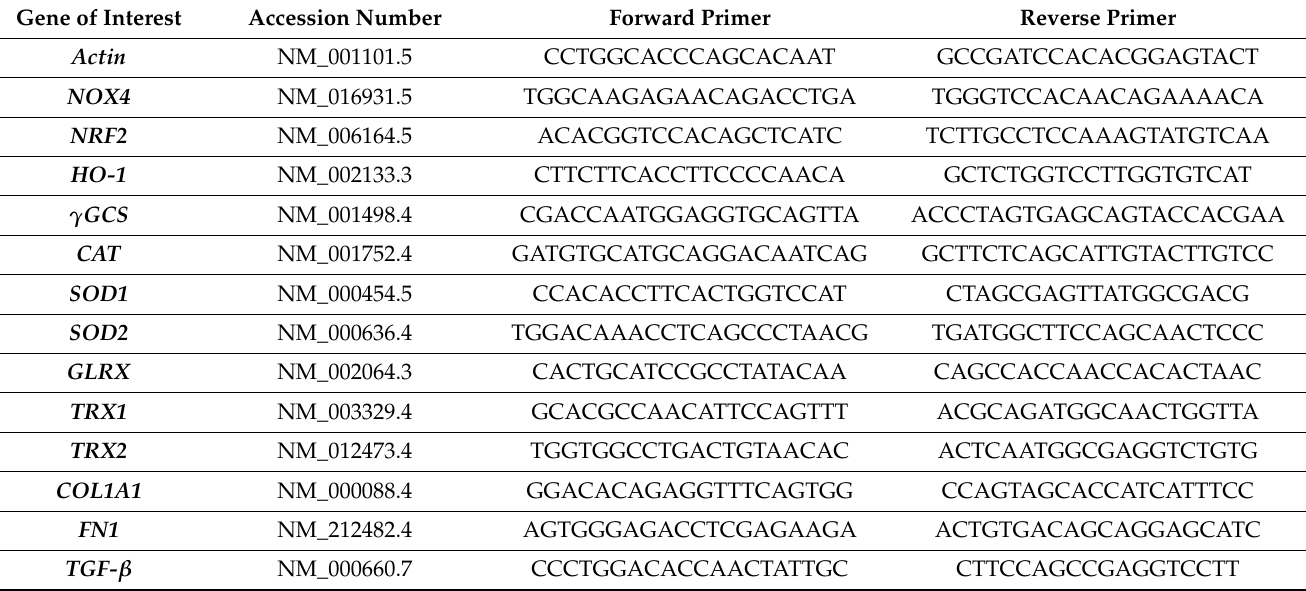
Table 2. Human RT-PCR forward and reverse primer